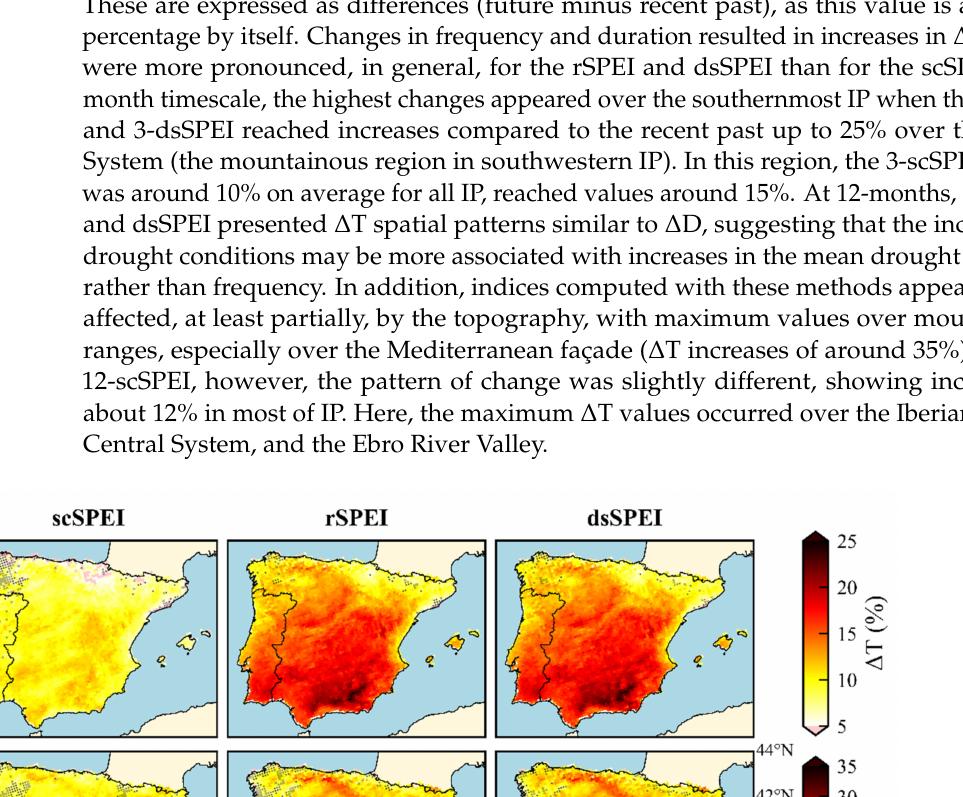
Figure 6. As Figure 5, but for the mean drought duration ( ∆ D, %). Changes in the percentage of time spent in droughts ( ∆ T) are displayed in Figure 7.